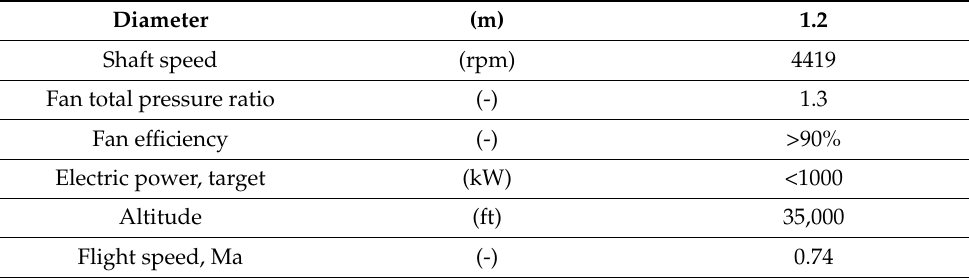
Table 1. TCT design table for aerodynamic design point